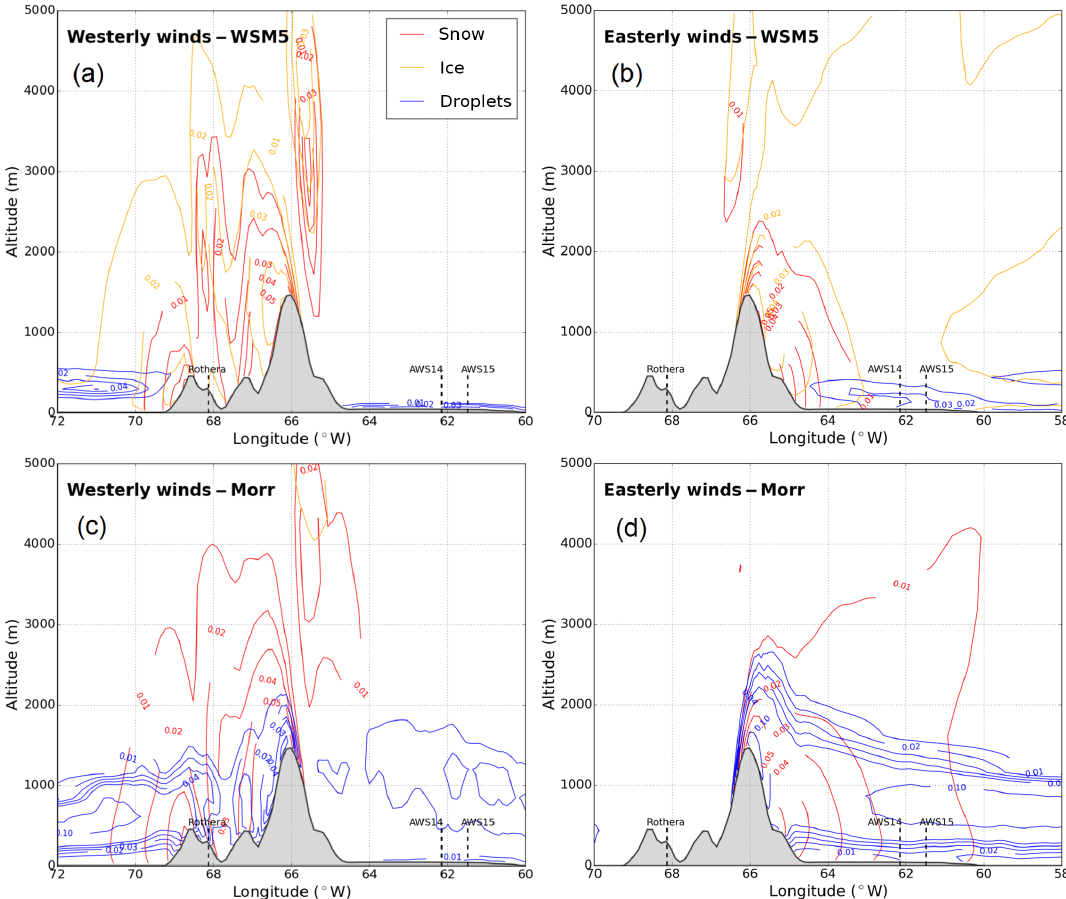
Figure 5. Transect of the cloud microphysics for WSM5 (a, b) and Morrison (c, d) averaged over a period (7–10 January 2011) dominated by westerly winds (a, c) and over another period (11–17 January 2011) dominated by easterly winds (b, d) . The transect is approximately centred on Rothera Research Station (67.586 ◦ S), and it is an average over a 100km wide latitudinal band. The longitudes of Rothera, AWS14, and AWS15 are